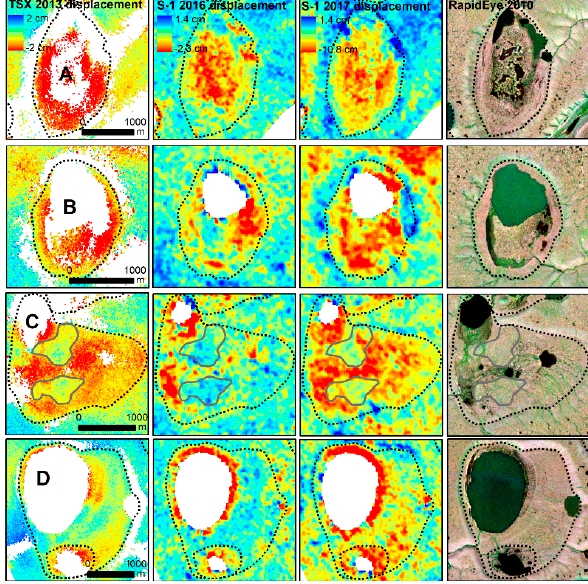
Figure 14. Local comparisons of subsets of InSAR displacement maps from TerraSAR ‐ X in the vertical direction between 7 June and 14 September 2013 [14], Sentinel ‐ 1 in the line ‐ of ‐ sight direction between 22 July and 26 September 2016, Sentinel ‐ 1 in the line ‐ of ‐ sight direction between 29 June and 15 October 2017 and RapidEye optical image from 2010. Large water bodies were clipped out. Thermokarst basins are delineated manually in dashed black. The location of the lettered basins can be found in Figure 13. The colour scale is the same for each map in a column.